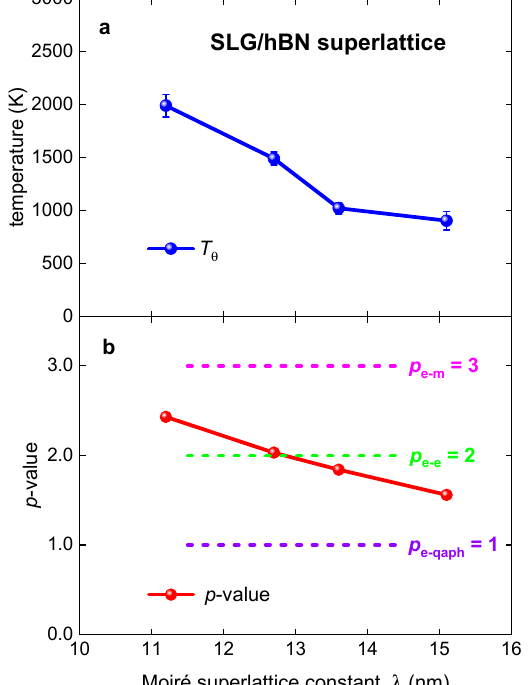
Figure 3. Summarized results for Moiré SLG/hBN superlattices (raw data reported by Wallbank et al. [10]). ( a ) deduced Debye temperature; ( b ) deduced p -value in Equation (7). Characteristic val-